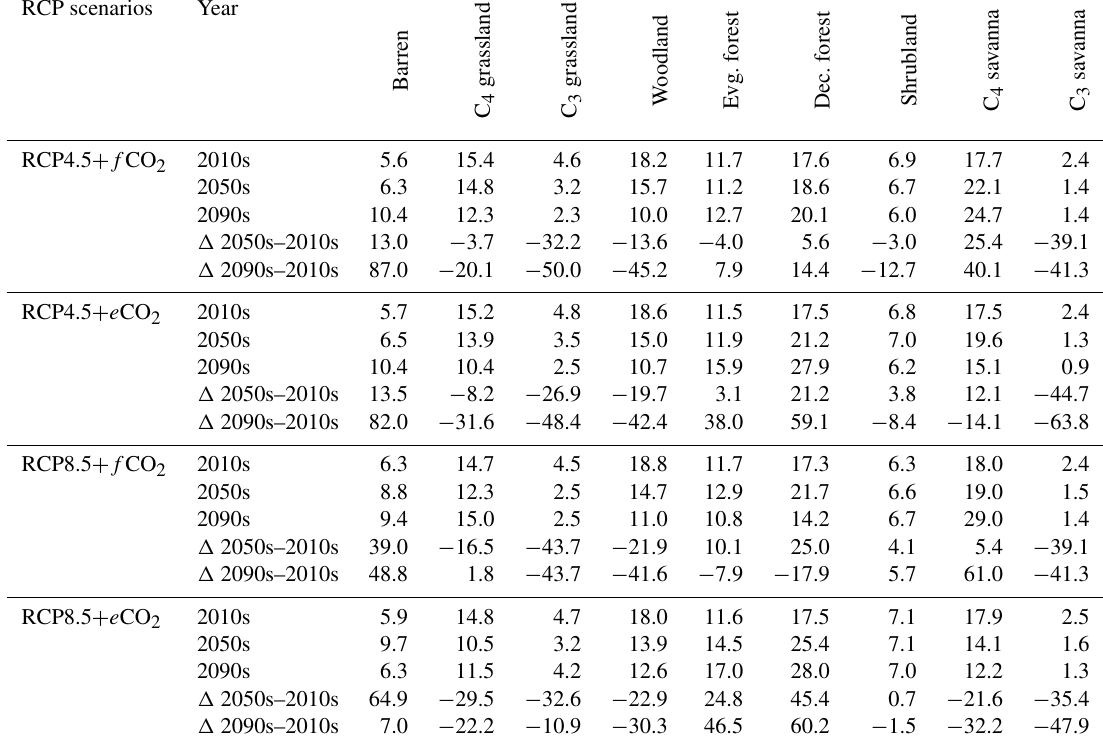
Table 1. Biome cover (in %) for the 2000s, 2050s and 2090s, and percent (%) change in biome cover from the 2000s to the 2050s and the 2000s to the 2090s under RCP4.5 and RCP8.5 with fixed and elevated CO 2 . (cid:49) indicates percent change in biome cover between time periods. RCP